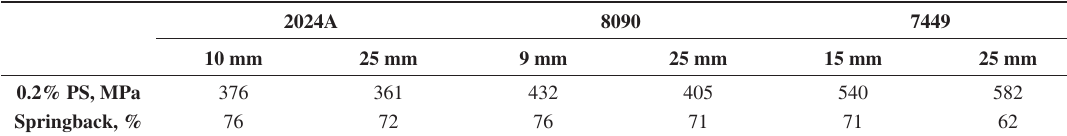
Table 7. Effect of plate thickness on proof stress and springback - adapted from 9 .